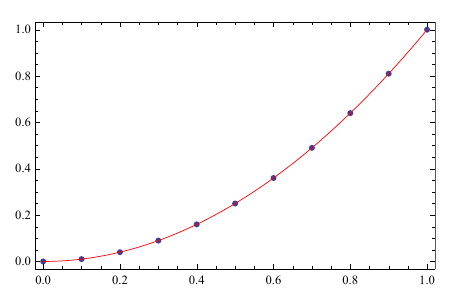
Figure 2. Approximate solution of Example 3.